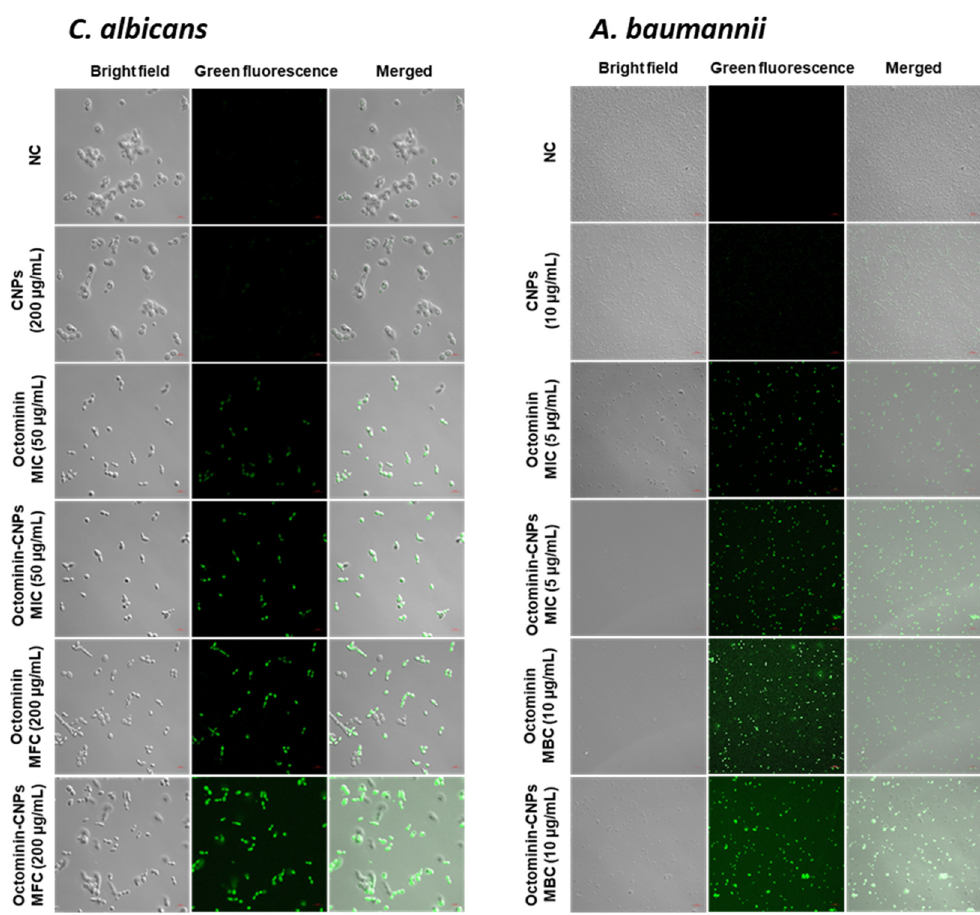
Figure 6. Comparison of ROS generation in C. albicans and A. baumannii with treatments between Octominin-CNPs, Octominin, and CNPs. C. albicans were treated with PBS (negative control), CNPs (200 µg/mL), Octominin MIC (50 µg/mL), Octominin MFC (200 µg/mL), Octominin-CNPs MIC (50 µg/mL), and Octominin-CNPs MFC (200 µg/mL). A. baumannii was treated with PBS (negative control), CNPs (10 µg/mL), Octominin MIC (5 µg/mL), Octominin MBC (10 µg/mL), Octominin-CNPs MIC (5 µg/mL), and Octominin-CNPs MBC (10 µg/mL). After 12 h of treatment, fungi/bacteria were separated and stained with H 2 DCFDA. Fungi/bacteria were observed under confocal microscopy at excitation and emission wavelengths of 488 and 535 nm, respectively. The scale bar denotes 10 µm. NC—Negative control.